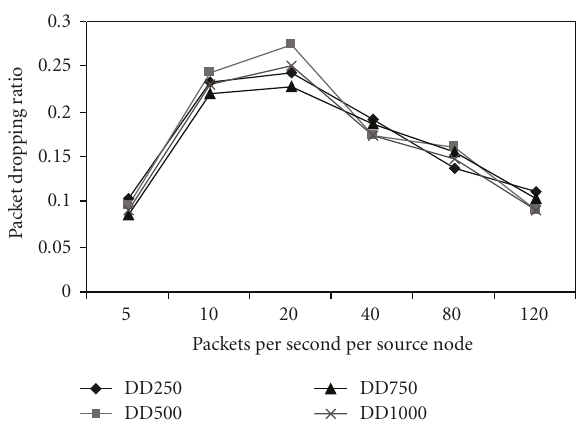
Figure 24: E ff ect of di ff erent DDNTs on the DA mechanism.